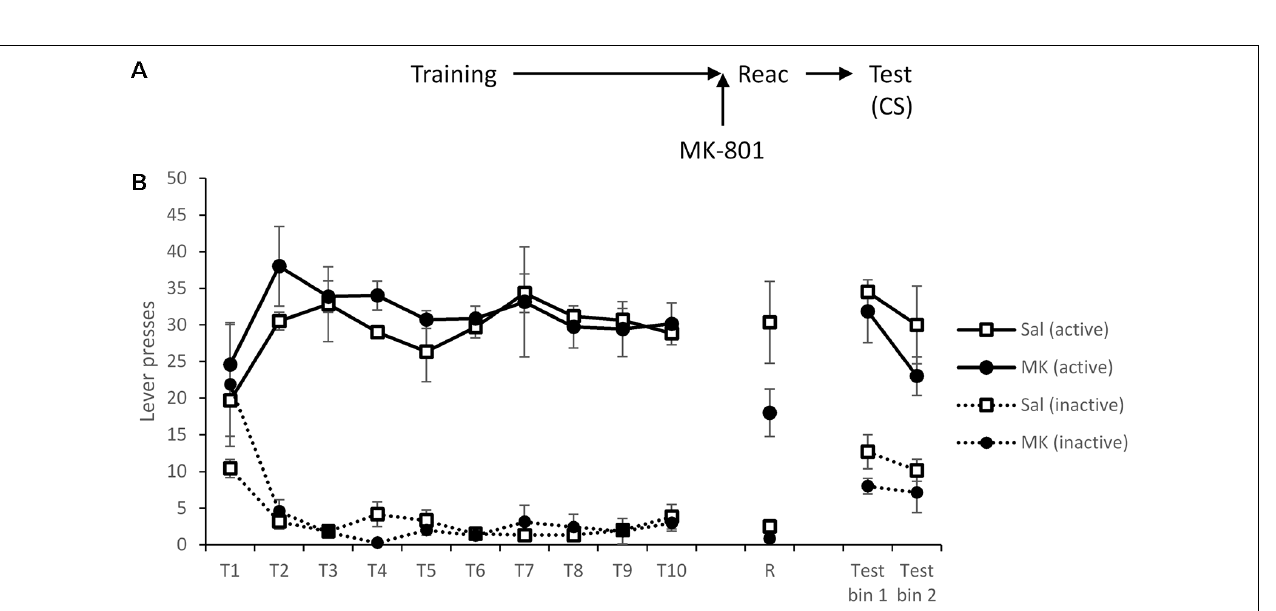
Experiment 3: Yohimbine-Induced Relapse = 0.061, BF inc = 0.061; MK- F ( 1,11 ) = 0.71, p = 0.42, η 2 p A third cohort learned to self-administer cocaine, with treatment 801: F ( 1,11 ) = 0.65, p = 0.44, η 2 = 0.056, BF inc = 0.33). p groups performing similarly prior to reactivation ( Figure 3